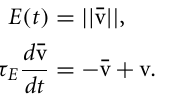
FIGURE 9 | Performances of visited regions through exploration . (A–C) : Basic system. (D–F) : System with adaptation. All plot points are color coded by their performance from blue to red (0.0 ≤ E ≤ 1.0, increase step of 0.2). (A,D) The same plots as Figure 7 except the points are colored by their performance levels.